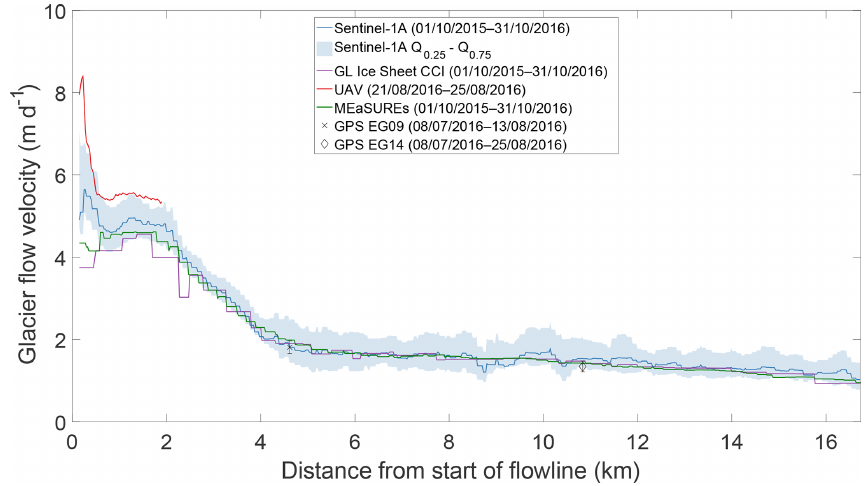
Figure 13. Mean annual flow speed along the central flowline (see Fig. 1) between 1 October 2015 and 31 October 2016 (13 months) for different products, starting at the glacier’s terminus. In red, the reference flow speed based on the 4d UAV mosaics acquired on 21 and 25 August 2016 is